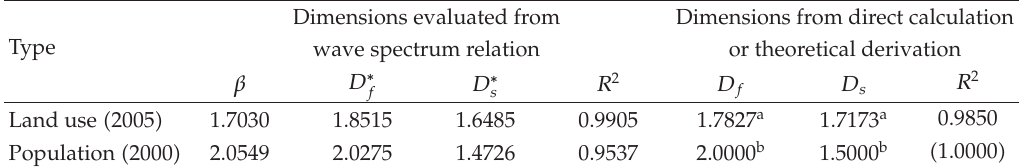
Table 4: Fractal dimensions, spectral exponents, and related statistics of land use and population distribution in Beijing. Dimensions evaluated from Dimensions from direct calculation Type wave spectrum relation or theoretical derivation ∗ D ∗ R 2 D f β D s f